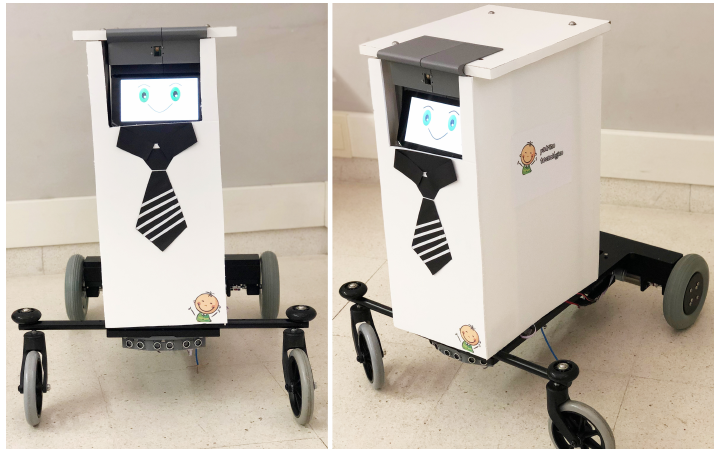
Figure 2. LOLA assistive